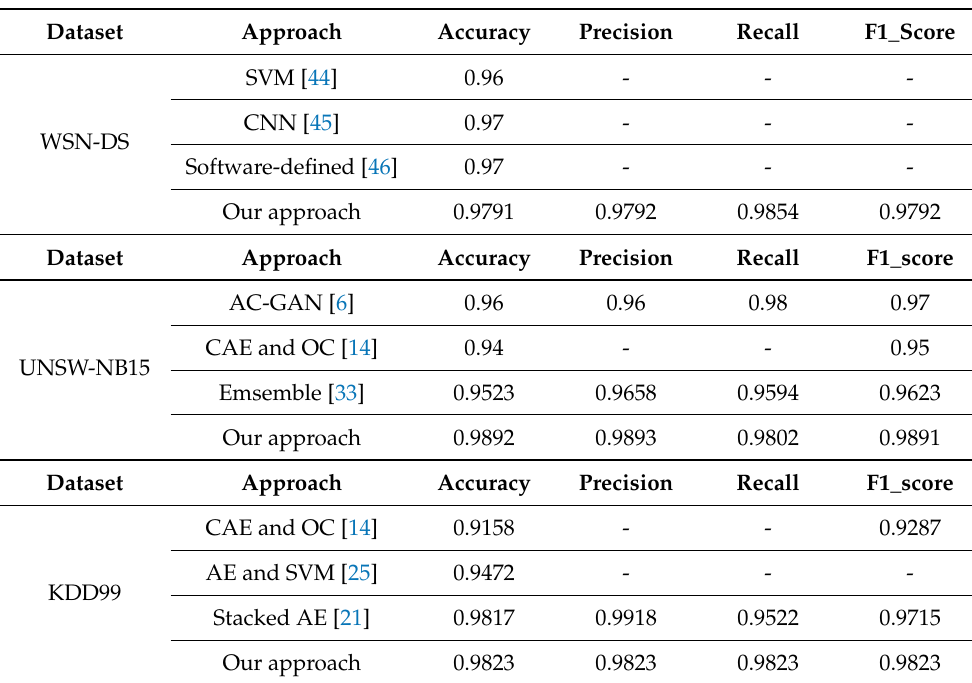
Table 10. Comparison of several